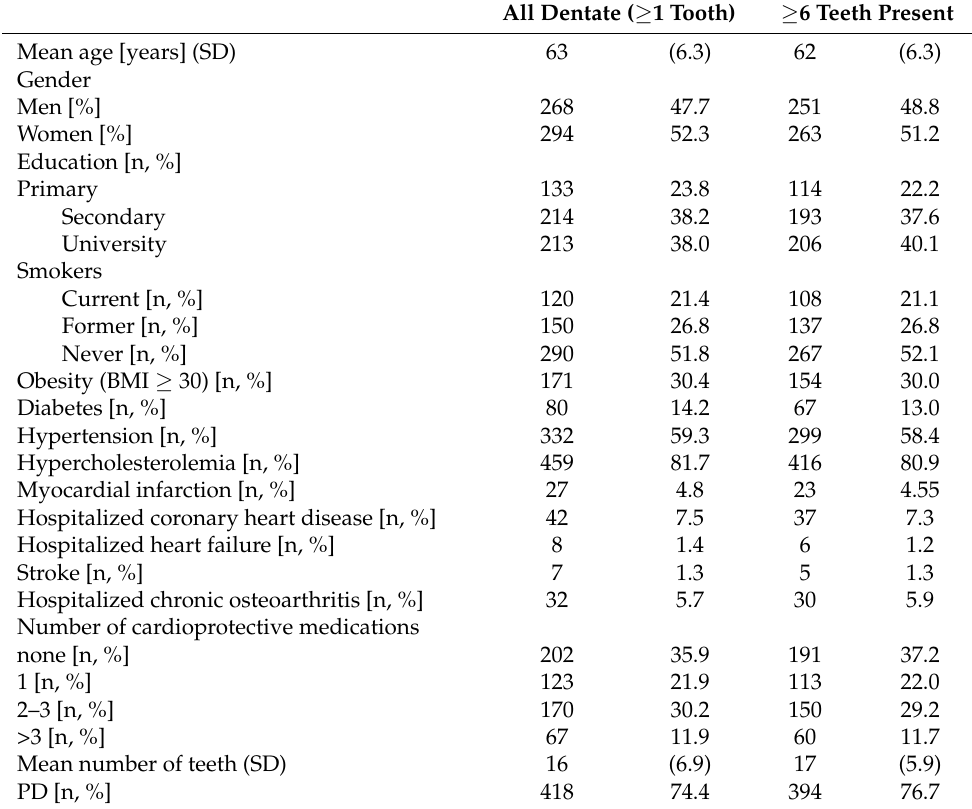
Table 1. Characteristics of the dentate population of the